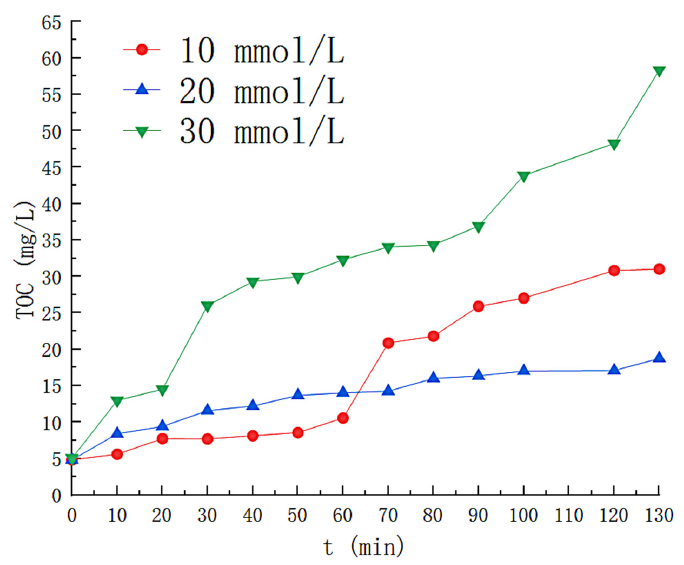
Figure 11. Effect of hydrogen peroxide concentration on TOC concentration.